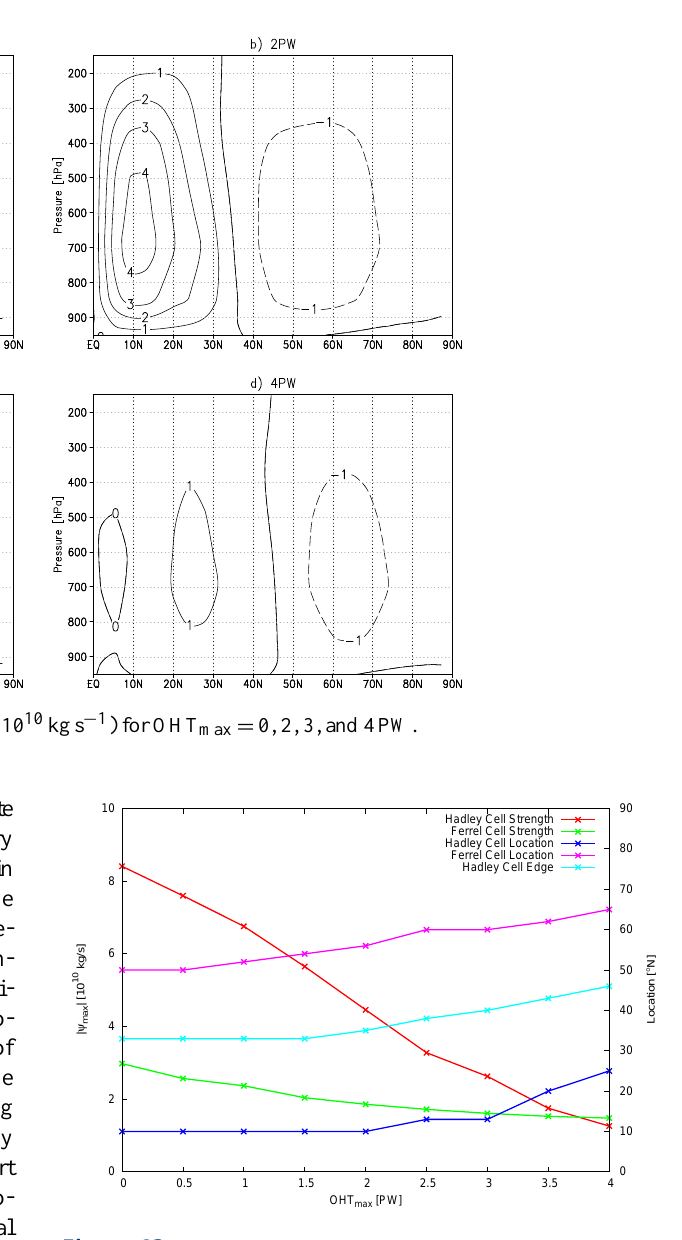
Figure 13. Climatological annual mean mass stream function (Northern Hemisphere): strength (in 10 10 kgs − 1 ) and location (in ◦ N) of Hadley and Ferrel cell for all